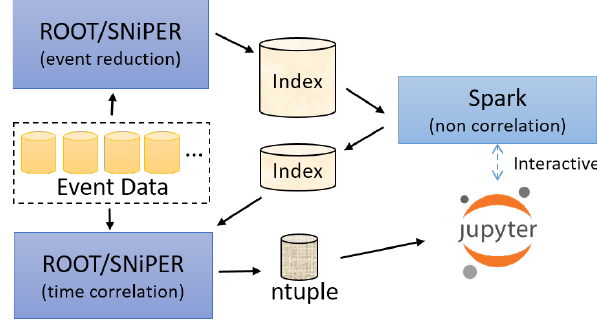
Figure 4. Analysis with Spark and